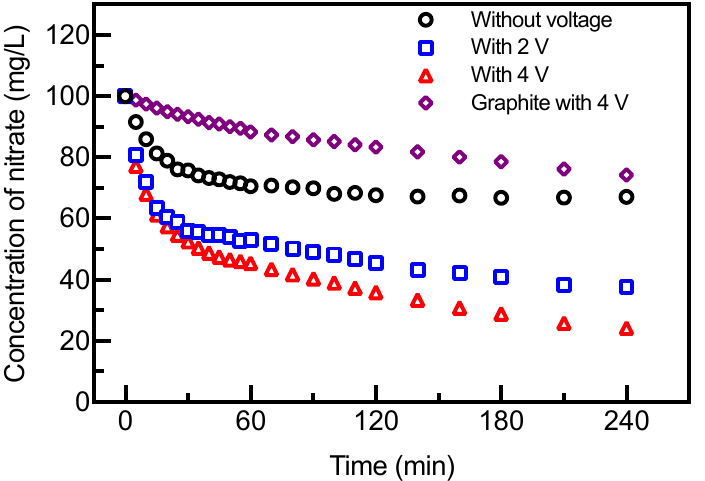
Figure 4. Removal of nitrate from simulated groundwater by the biochar electrode. [NO 3 − ] 0 = 100 mg/L, V = 600 mL, T = 25 ◦